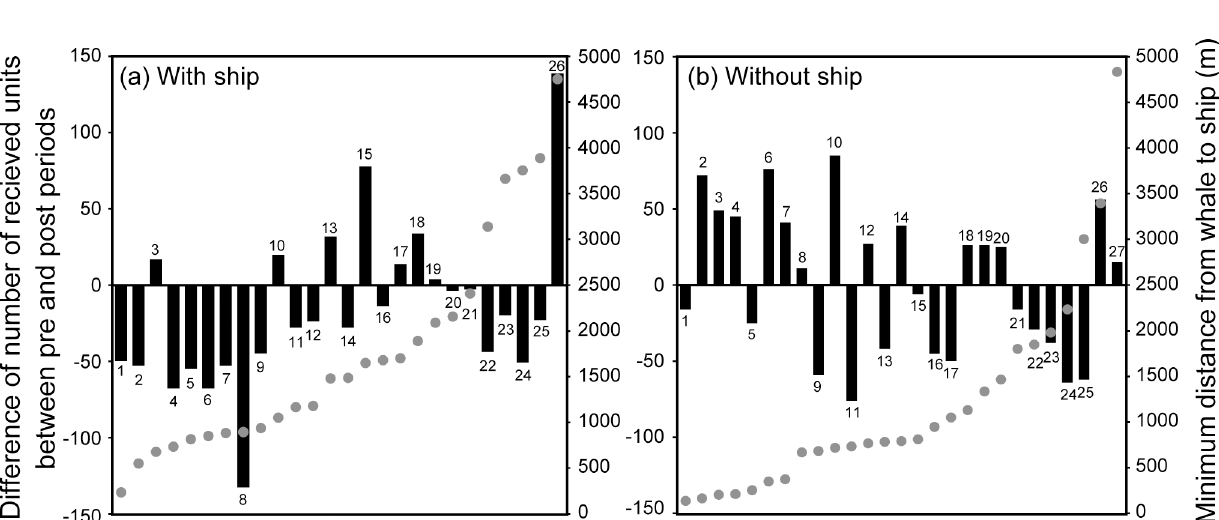
Fig 7. Relationship between singer’s location and an increase or decrease of song. These figures show the difference in the number of received units between pre- and post-test periods (black bars) and minimum distance from each whales to the target ship (gray circles) when the ship was (a) present and (b) absent. Without the ship operating, we calculated the distance between the singer and the virtual ship trajectory. When the ship was present, at distances up to 1200 m, 10 of 12 whales reduced song units. The number of received units after the ship passed was significantly less than that before the ship passed (Wilcoxon signed rank test, P = 0.005, n = 12). However, nearly same number of whales increased or decreased the unit production over the 1400 m range (Wilcoxon signed rank test, P = 0.975, n = 14). When the ship was absent, no trend could be observed under the 1200 m range from the ship trajectory ( P = 0.528, n = 18). Observed whales are ordered from left to right acording to the minimum distance from the target ship (X-axis). Numbers in the graph show the serial number of observed whales.